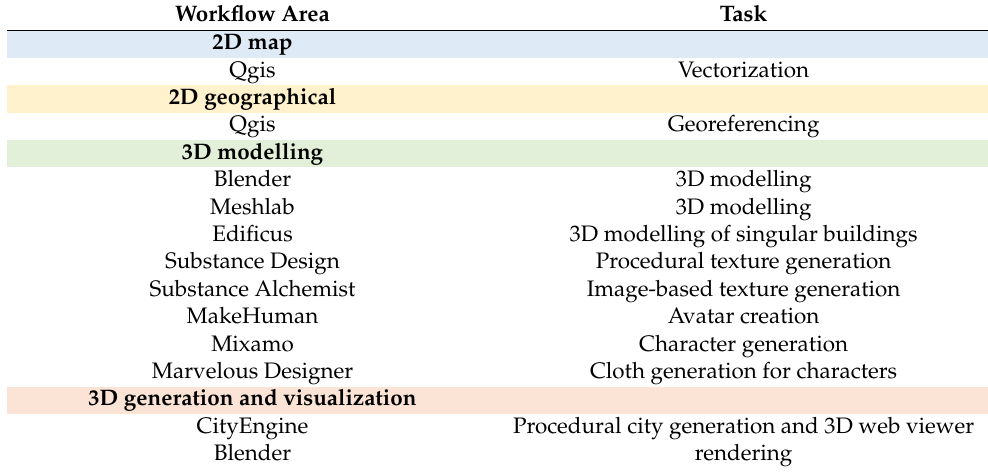
Table 1. Software tools used in this project.